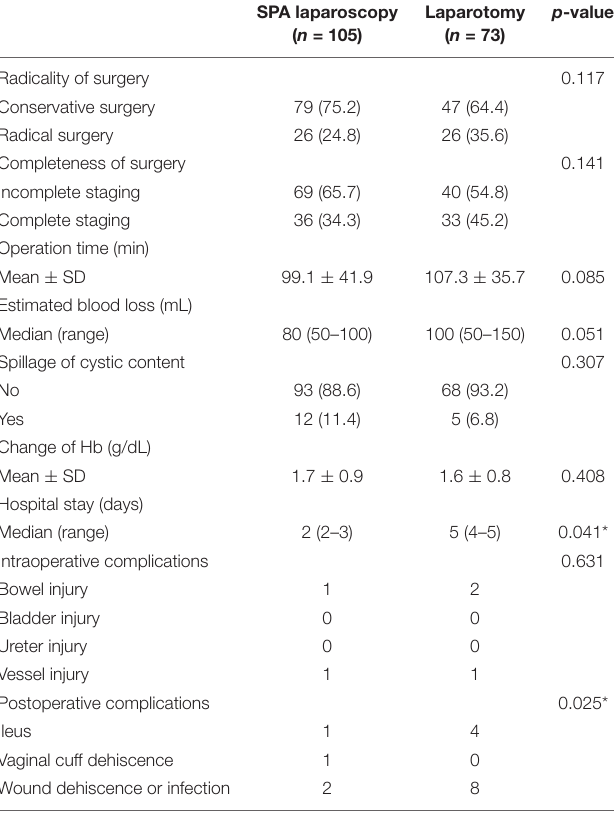
TABLE 2 | Surgical outcomes according to the initial surgical approach. TABLE 3 | Comparison of misdiagnosis and same-diagnosis of frozen sections